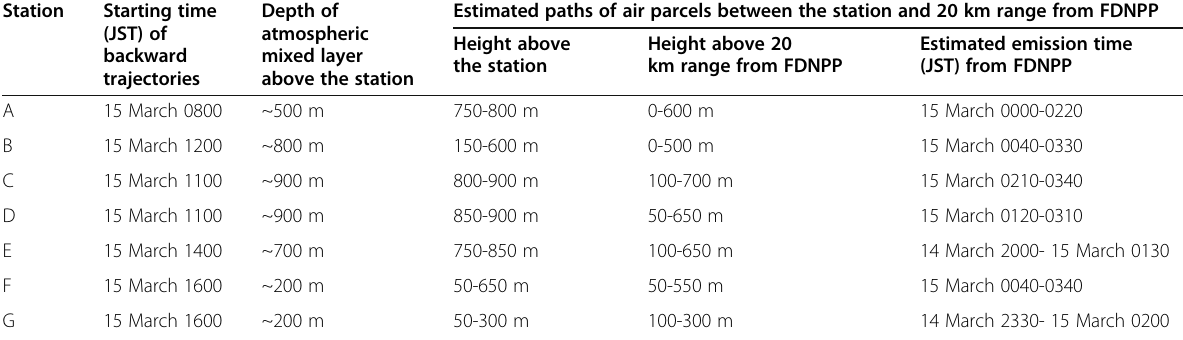
Table 2 Summary of the backward trajectory analysis for seven monitoring stations (A~G) Station Starting time Depth of (JST) of atmospheric backward trajectories